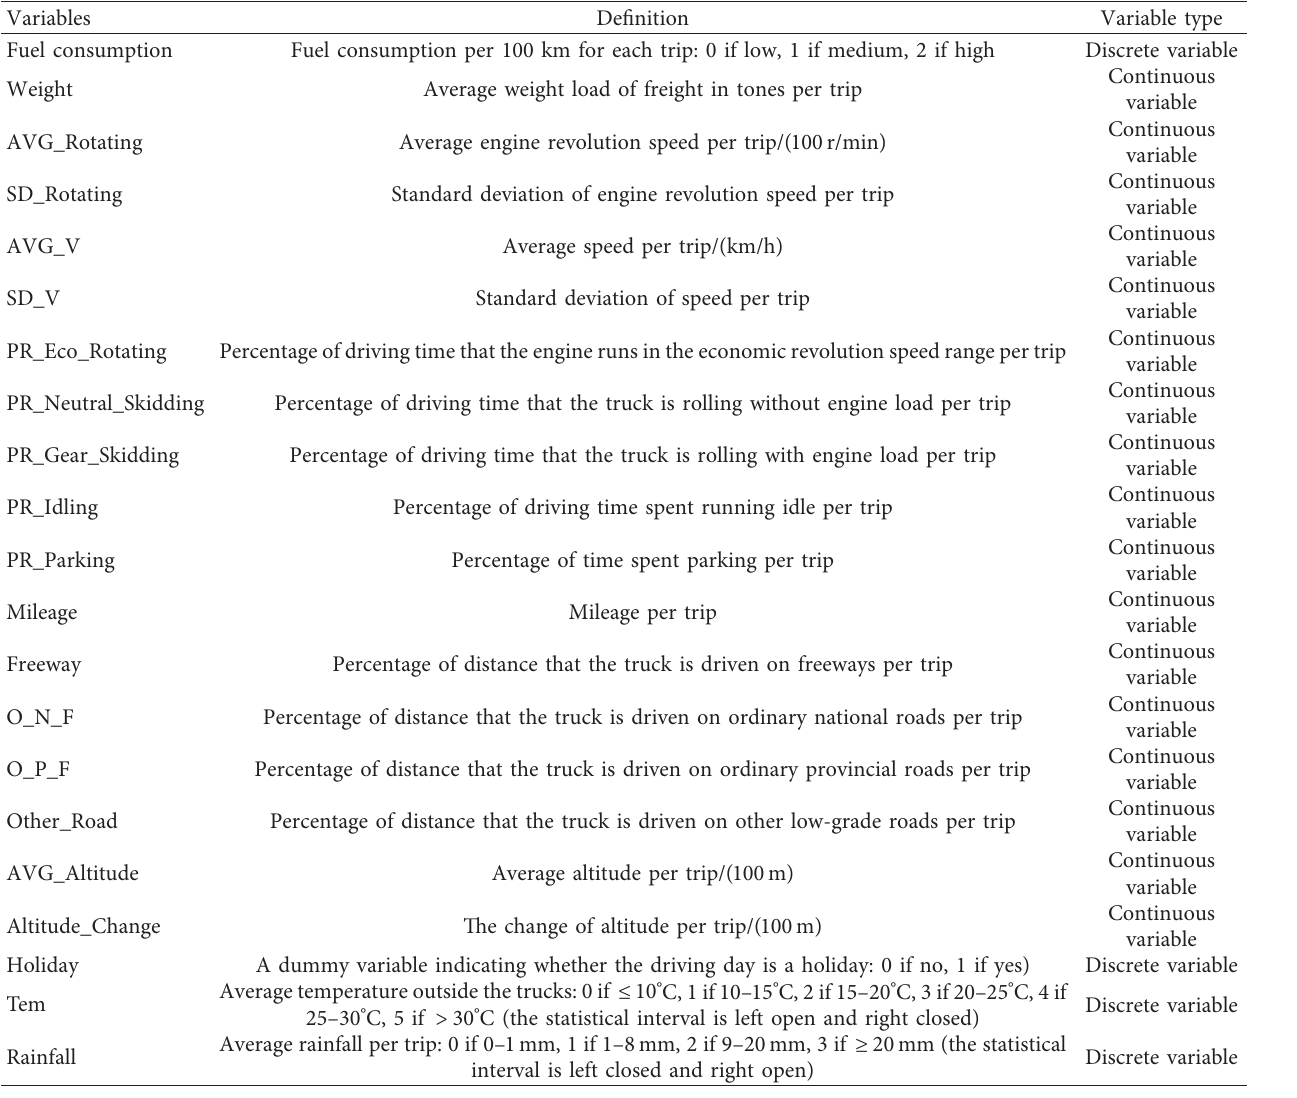
Table 3: The data obtained from the advanced on-board fleet management